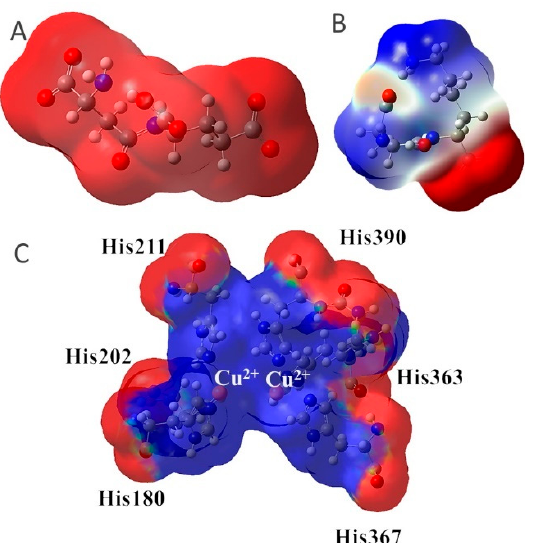
Figure 4. Maps of electrostatic potential for ( A ) Lig2, ( B ) Lig4, and ( C ) the active site of TYR.